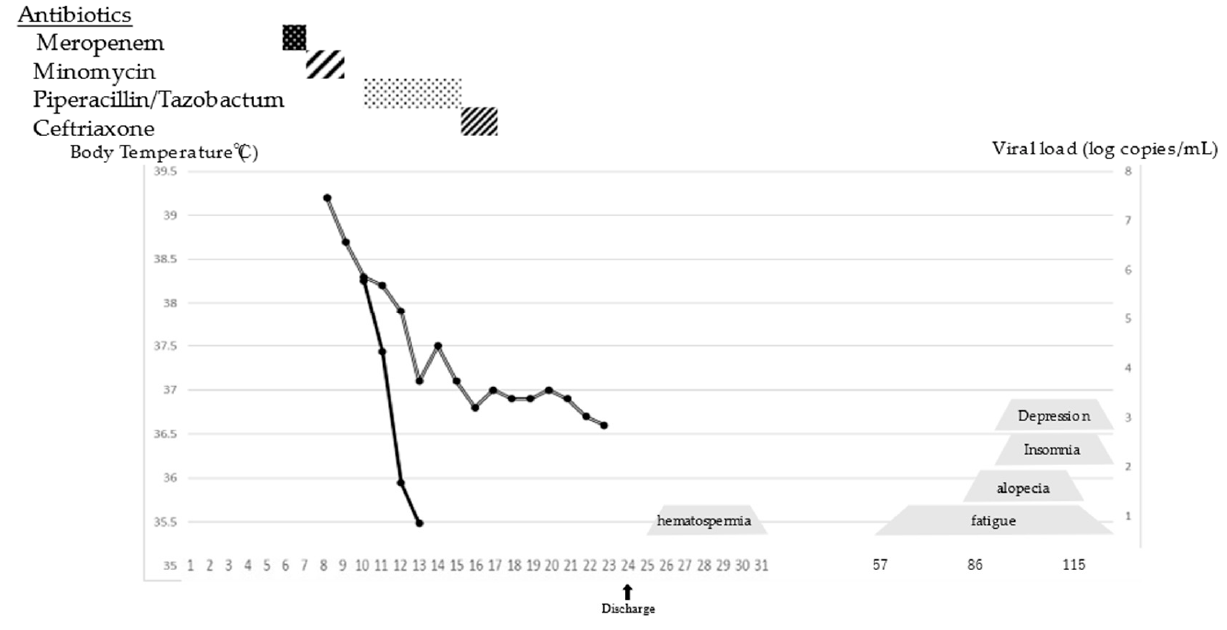
Figure 2. Timeline for the patient’s symptoms, body temperature(double line), viral load(solid line), and administration of broad-spectrum antibiotics.